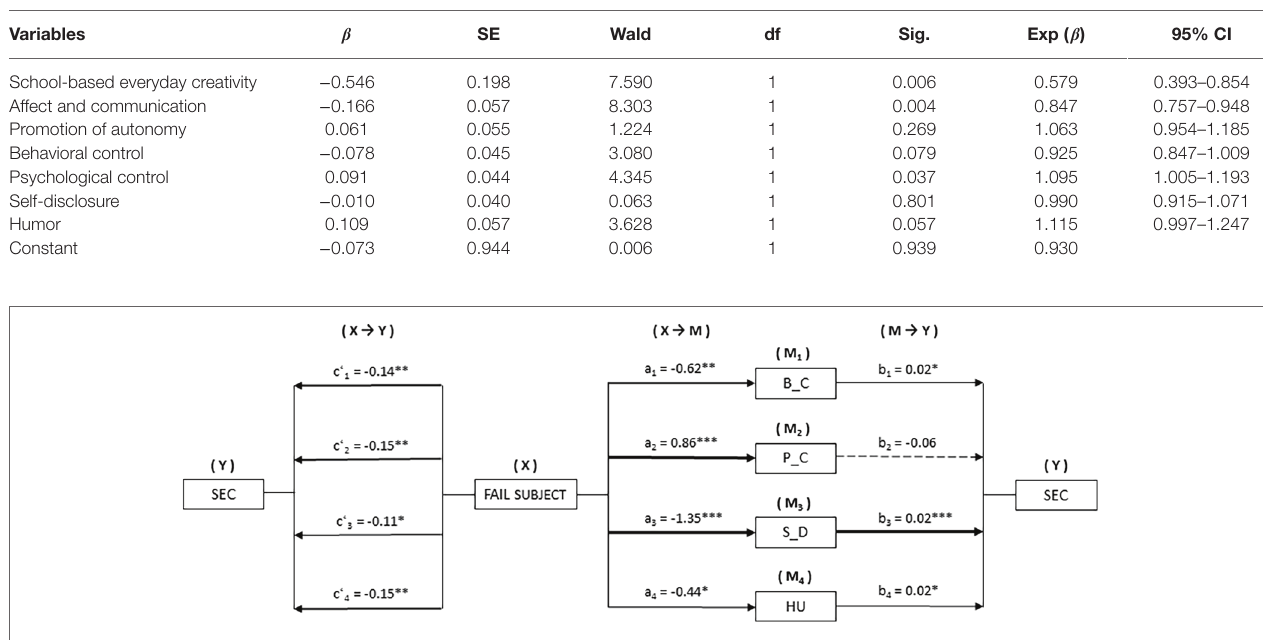
FIGURE 1 | Mediation model for parenting styles on the relationship between failing a subject and school-based everyday creativity. *p < 0.05; **p < 0.01; ***p < 0.001.